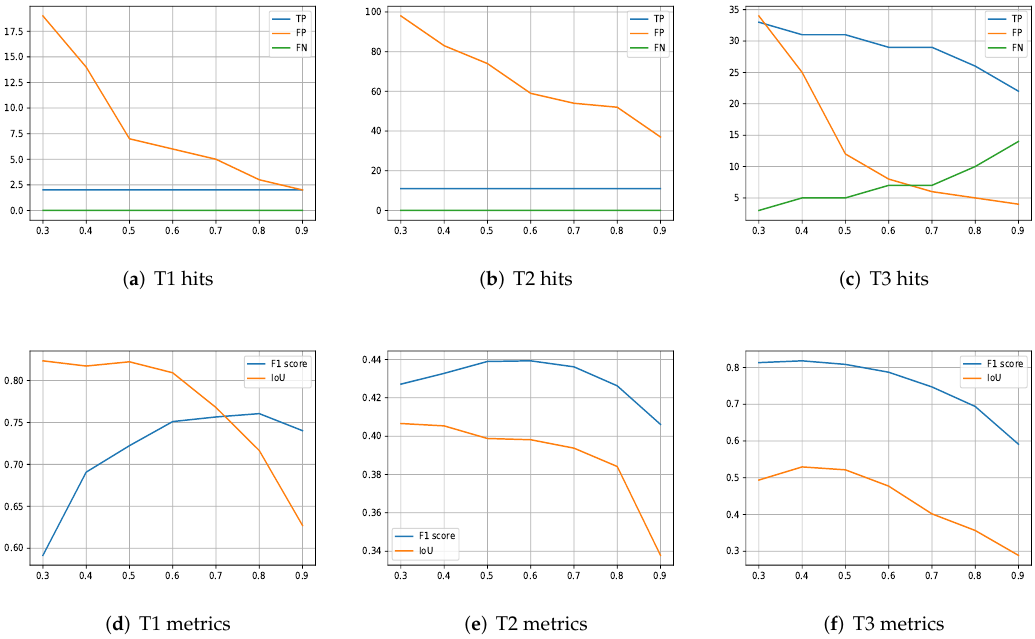
Figure 10. The x-axis always denotes the value of the rounding threshold τ . ( a – c ) number of True Positive (TP), False Positive (FP), and False Negative (FN) detection obtained by using a different threshold τ on the soft output of the OFCN. ( d – f ) values of F1 score and IoU for different τ .